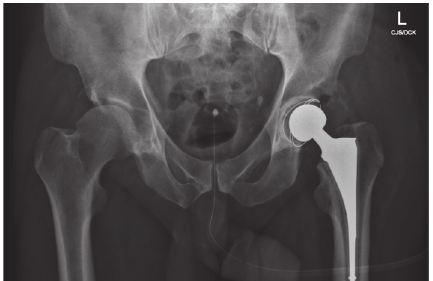
Figure 3: Postoperative radiograph demonstrating first-stage cemented total hip replacement with 48/32 mm Stryker RimFit Ace-tabular cup and size 9 Biomet Simplex cement spacer.